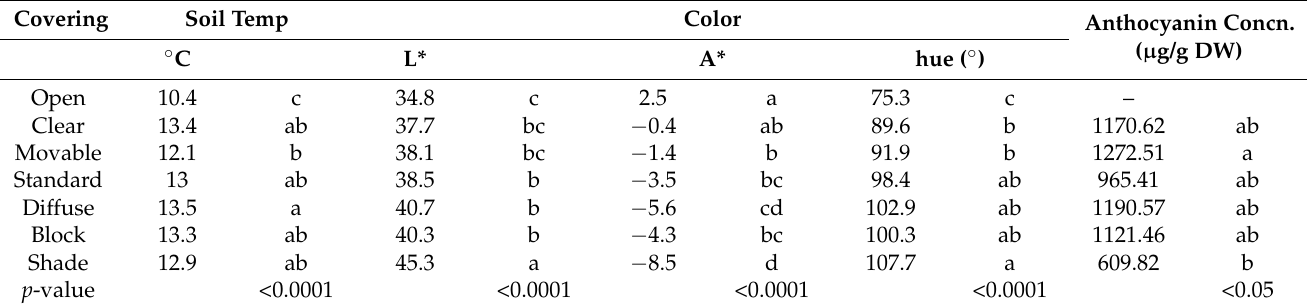
Table 4. Effect of high tunnel covering 1 on average soil temperature, color based on L* ( − black to +white), A* ( − greenness to +redness), and hue angle [tan − 1 (b*/a*)], and anthocyanin concentration of lettuce grown in Olathe, KS in fall 2017. Within the same column, means 2,3,4 with different letters are different ( p ≤ 0.05), Tukey’s HSD. Covering Soil Temp Color Anthocyanin Concn.